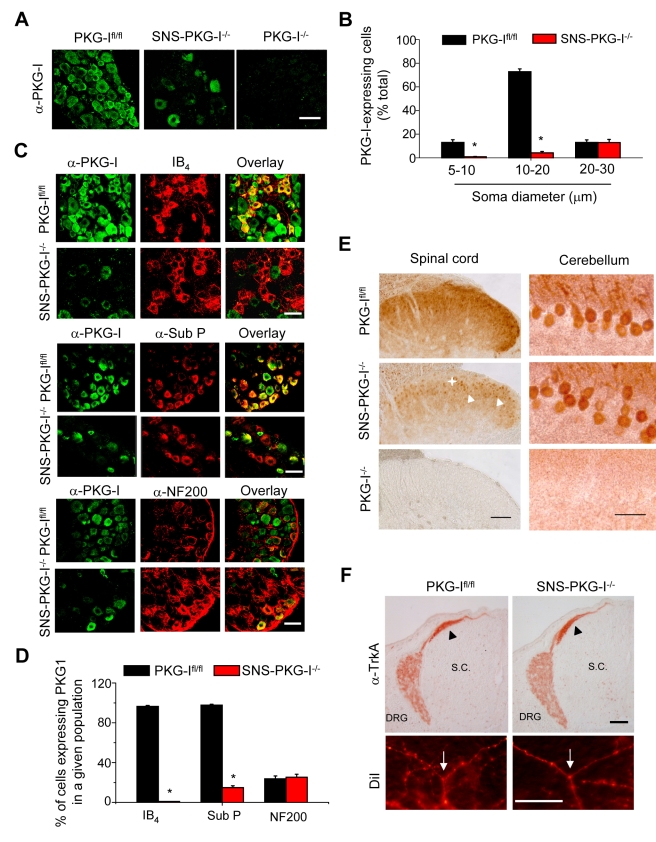
Nociceptor-specific deletion of PKG-I and lack of developmental defects in SNS-PKG-I−/− mice.(A) Immunoreactivity for an anti-PKG-I antibody was detected widely in DRG neurons of mice carrying floxed PKG-I alleles (PKG-Ifl/fl) and was lost either selectively in SNS-PKG-I−/− mice or entirely in global PKG-I−/− mice. (B) Quantitative size analysis of neurons of the dorsal root ganglia (DRG) expressing PKG-I in SNS-PKG-I−/− mice and PKG-Ifl/fl littermates showing specific loss of PKG-I in small-diameter neurons in SNS-PKG-I−/− mice. Data in panels represent mean ± S.E.M.; n = 10–15 DRG sections each. (C, D) Typical examples (C) and quantitative summary (D) from dual immunofluorescence experiments showing that in SNS-PKG-I−/− mice, PKG-I immunoreactivity is abrogated from nociceptors, i.e. Isolectin-B4-positive (IB4) or Substance P-positive (α-Sub P) neurons, but retained in neurofilament 200-positive (α-NF200) large diameter neurons, in comparison with control littermates (PKG-Ifl/fl). n = 10–15 DRG sections each; * p<0.001, ANOVA, post hoc Fisher's test. (E) Typical examples of anti-PKG-I immunostaining in the brain (cerebellar Purkinje neurons are shown) and spinal dorsal horns of SNS-PKG-I−/− mice, their PKG-Ifl/fl littermates, and global PKG-I−/− mice. Spinal dorsal horns of SNS-PKG-I−/− mice showed a loss of anti-PKG-I immunoreactivity in the superficial neuropil (+), but distinct preservation of signals in cell bodies (arrowheads). (F) Typical examples of patterning of Trk-A-expressing sensory afferents (arrowheads in upper panels) and T-branching of DiI-labelled sensory afferents (arrows in lower panels) in the spinal cord in PKG-Ifl/fl mice and SNS-PKG-I−/− mice at embryonic day 13.5 (E13.5). Scale bars represent 50 µm in panel A, 50 µm in panels A and C, 100 µm for spinal cord and 50 µm for cerebellum in panel E, and 100 µm in panel F. DRG, dorsal root ganglia; S.C., spinal cord.